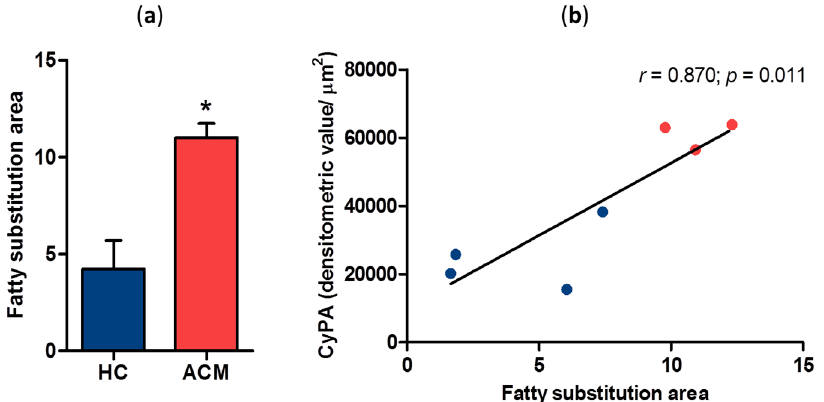
Figure 2. Quantification of fatty substitution area in HC and ACM RV sections ( a ). Correlation between CyPA expression levels and the extent of fatty substitution ( b ). * p value ≤ 0.05 at Student’s T test.